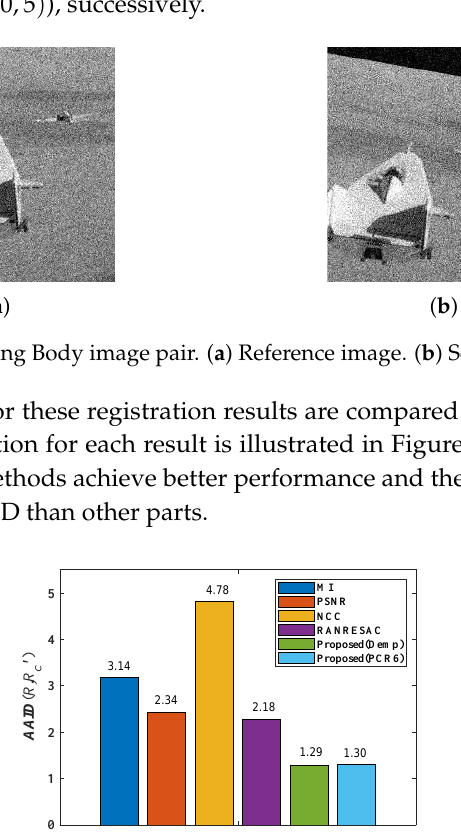
Figure 22. AAID evaluations of registration results for Lifting Body image pair.